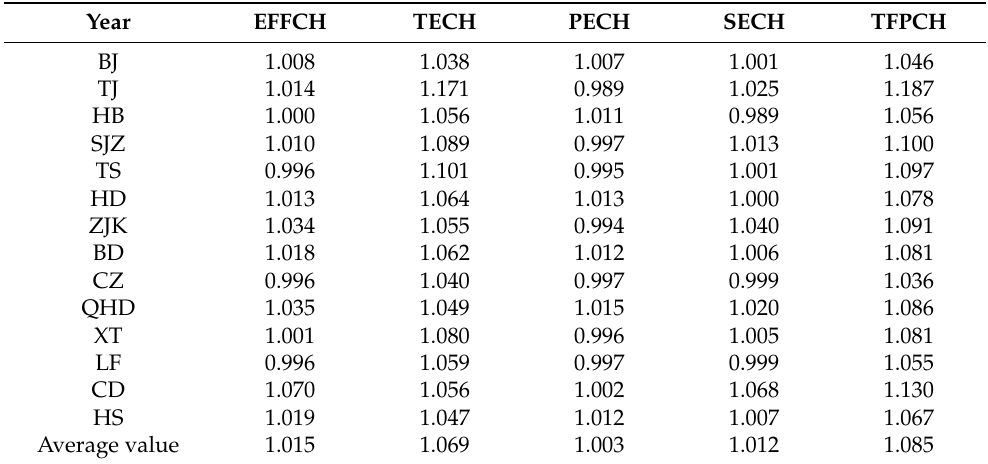
Table 7. The overall change index of EEUCL in the BTH urban agglomeration and its decomposition index from 2002 to